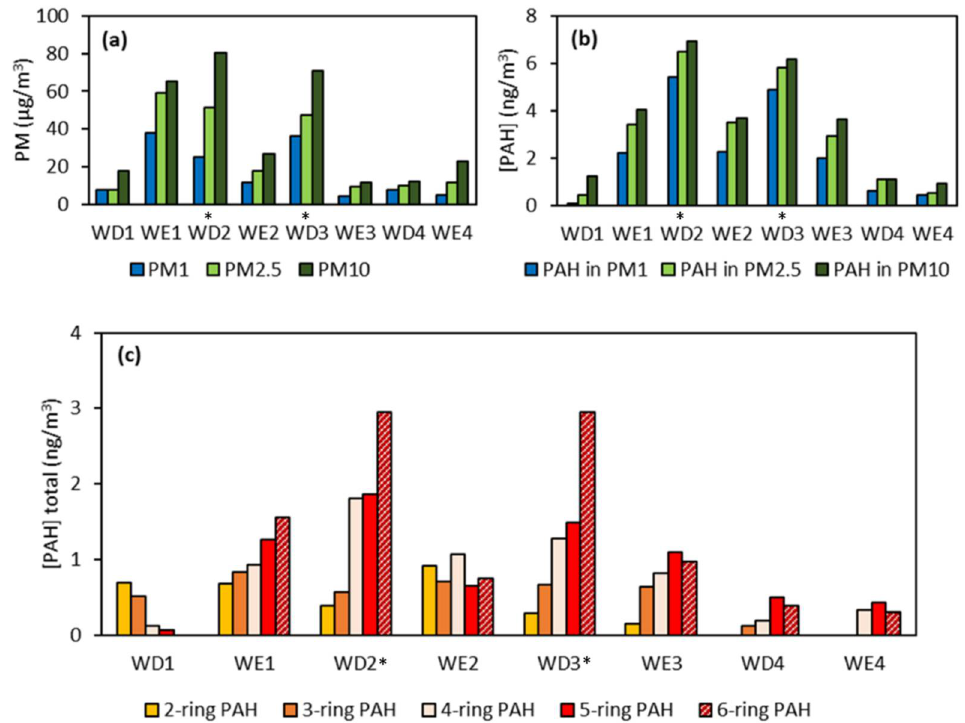
Figure 5. Temporal variation of PM and PAHs during the field campaign obtained with the impactor. ( a ) Temporal distribution of PM values, ( b ) temporal distribution of total PAH concentration corresponding to PM fractions, and ( c ) temporal distribution of total PAH concentration corresponding to ring number. (* used to indicate the sampling periods when the pollution episodes occurred.).